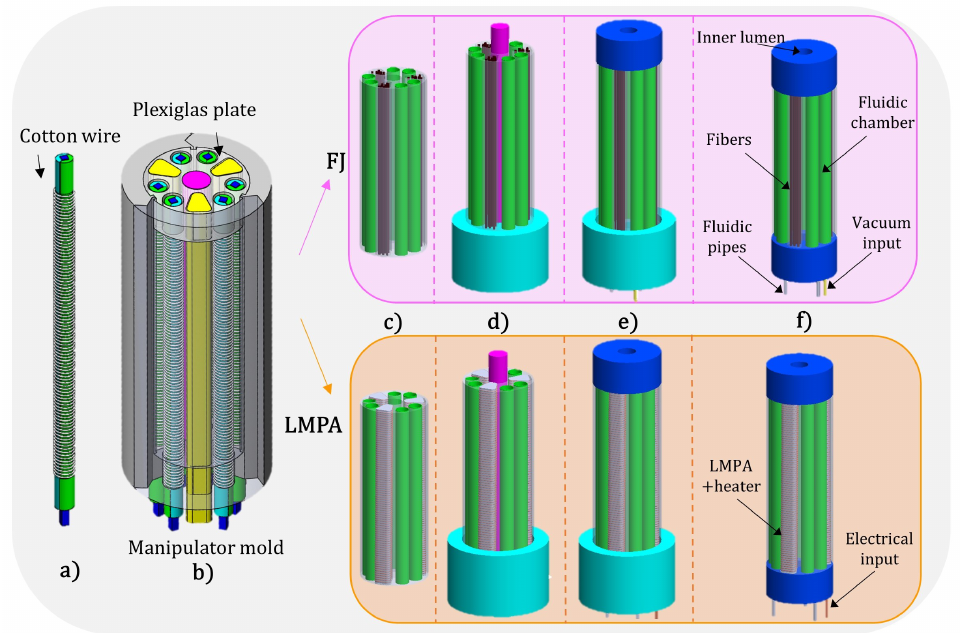
Figure 4. ( a – f ) Module manufacturing